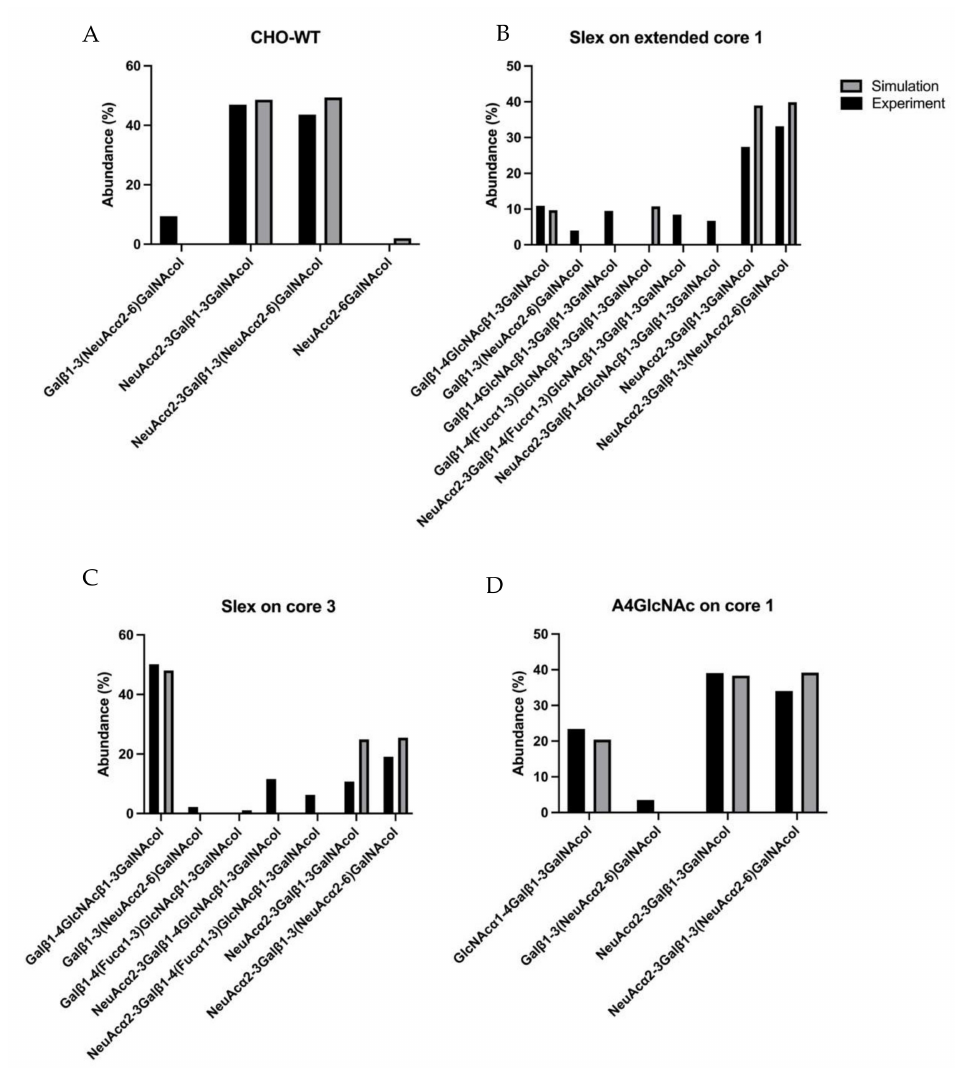
Figure 6. Predicted O -glycan profiles of four-experiment model. The abundance of predicted structures at the end of each model simulation is compared to the abundance measured experi- mentally. ( A ) CHO-WT model. ( B ) sLeX on extended Core 1 model. ( C ) sLeX on Core 3 model. ( D ) A4GlcNAc on Core1